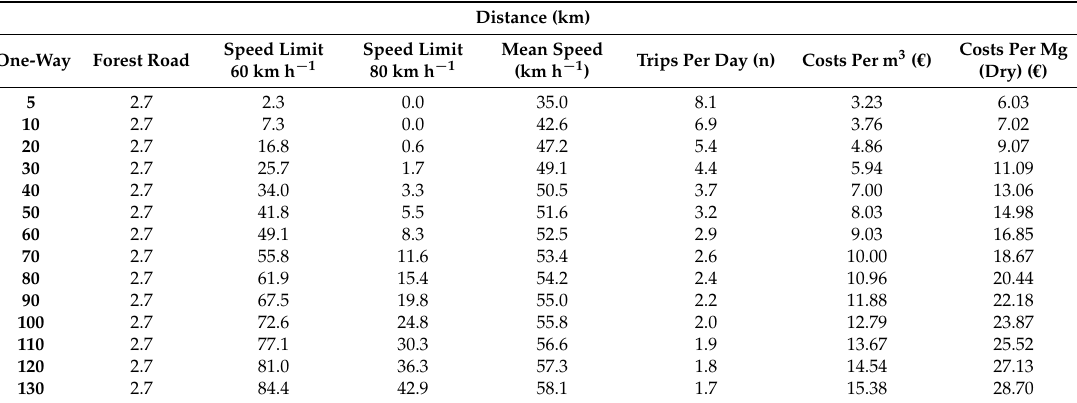
Table 3. Transportation speed and cost for distances between 5 and 130